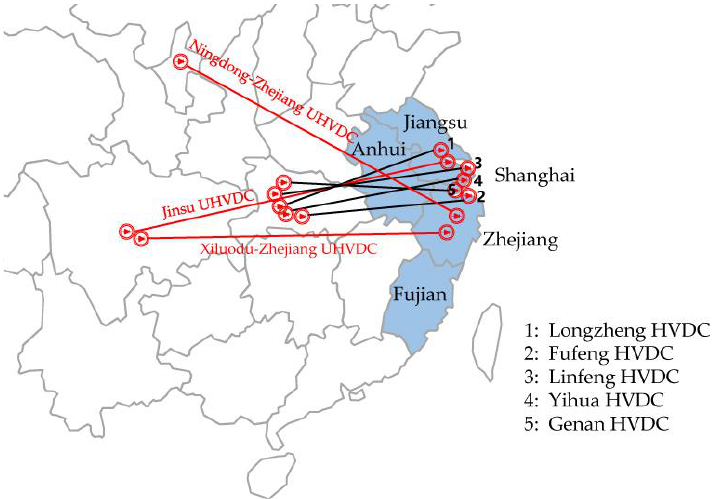
Figure 7. Schematic of the Eastern China Grid. Table 4. High voltage DC and ultra-high voltage DC transmission lines in the Eastern China Grid.